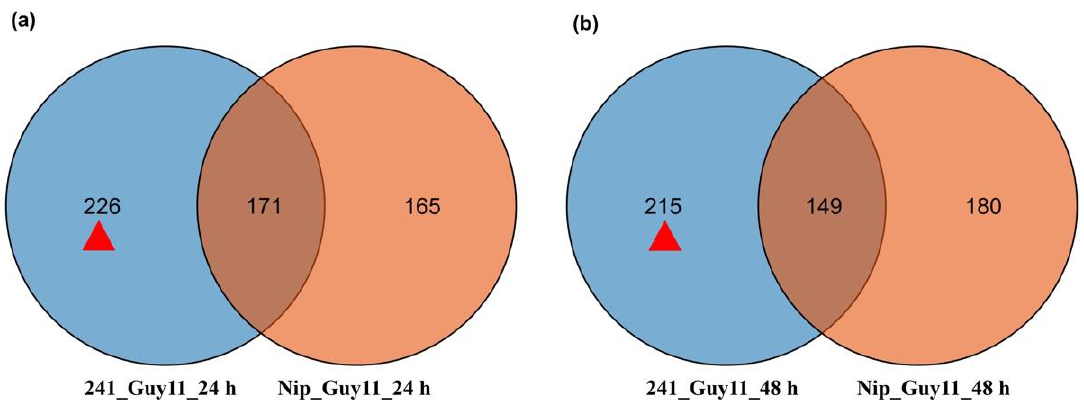
Figure 2. Comparison of differentially alternatively spliced genes (DASGs) of “Nipponbare” (Nip) and Pi21 -RNAi transgenic line during interaction with M. oryzae Guy11 (24 hpi and 48 hpi). ( a ) At 24 hpi. ( b ) At 48 hpi. The red triangles are the #241-specific DASGs. Red triangles represent numbers of #241-specific DASGs at 24 and 48 hpi.